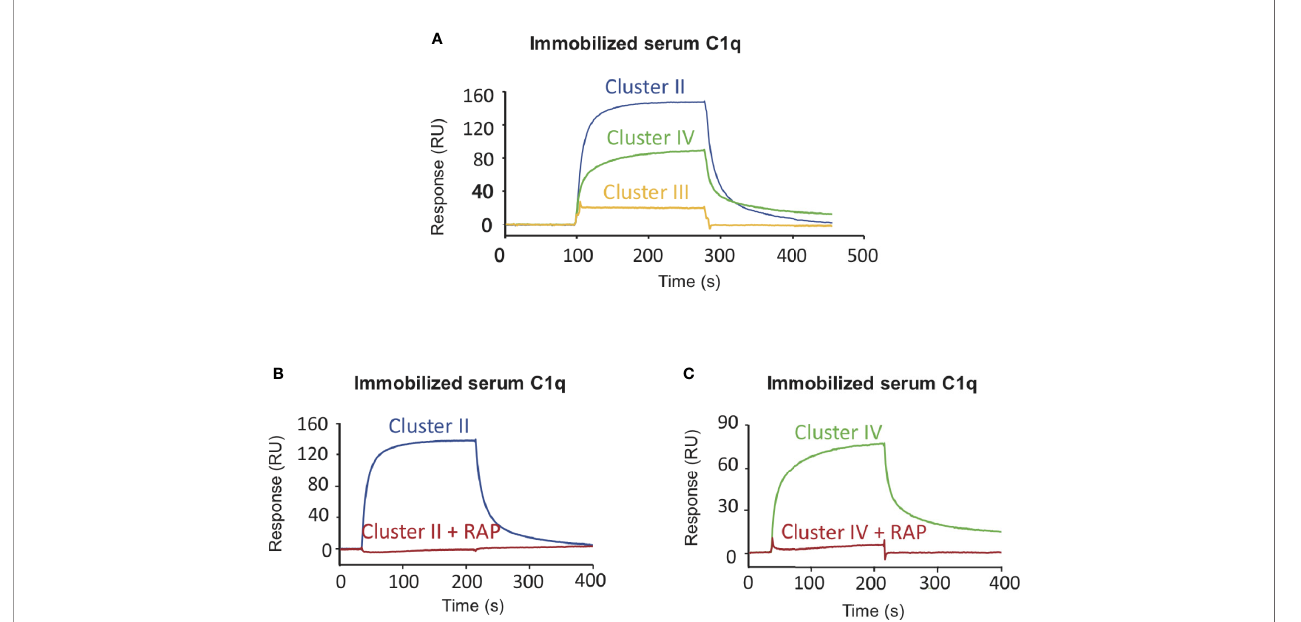
FIGURE 4 | LRP1 clusters II and IV interact with C1q. SPR analysis of LRP1 clusters II (blue curves), III (yellow curves) and IV (green curves) interactions over immobilized C1q, in the presence or absence of RAP. Clusters II, III and IV (500 nM in 50 mM TEA, 150 mM NaCl, 2 mM CaCl2, 0.005% P20, pH 7.4) were injected over immobilized serum C1q (17,500 RU) with or without RAP (500 nM). (A) comparison of the interaction curves in the absence of RAP for clusters II, III and IV. (B, C) Comparison of the binding of Cluster II (B) and Cluster IV (C) in the presence or in the absence of RAP.